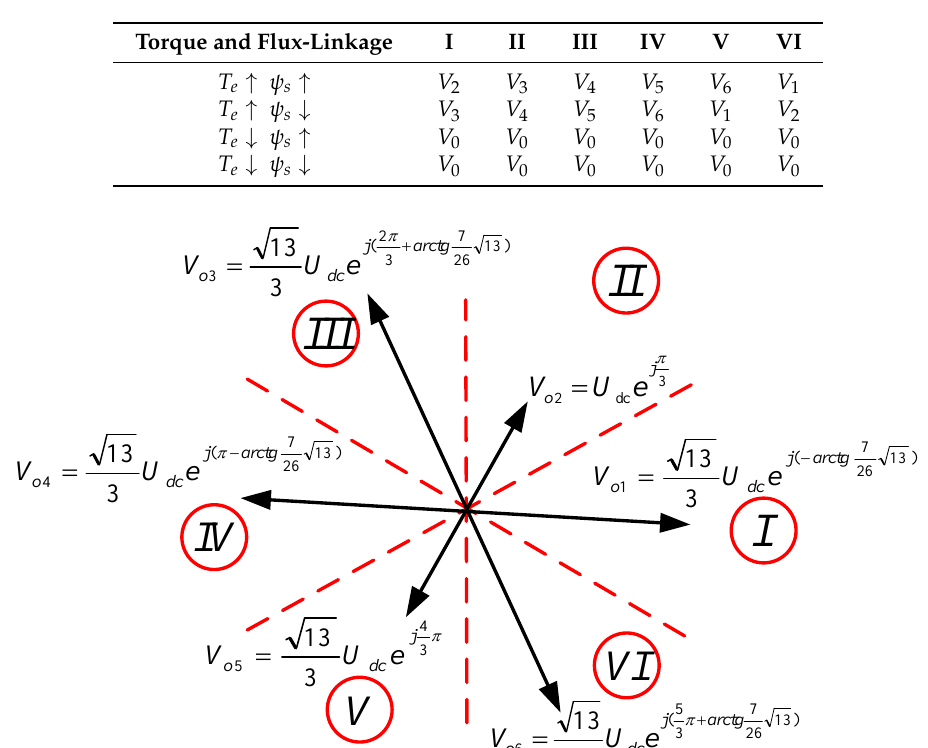
Table 1. Switch table.